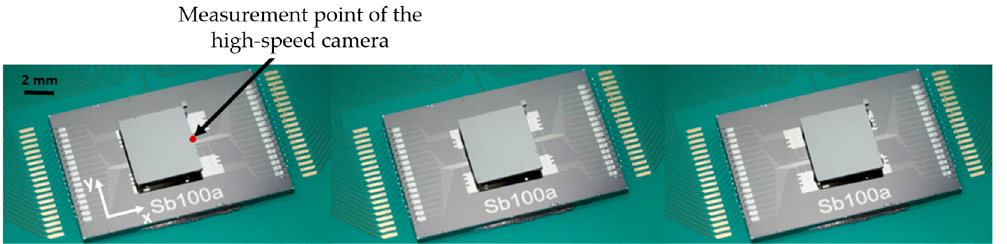
Figure 19. Three positions of the moving platform at 40 V with a switching period of t = 100 ms.